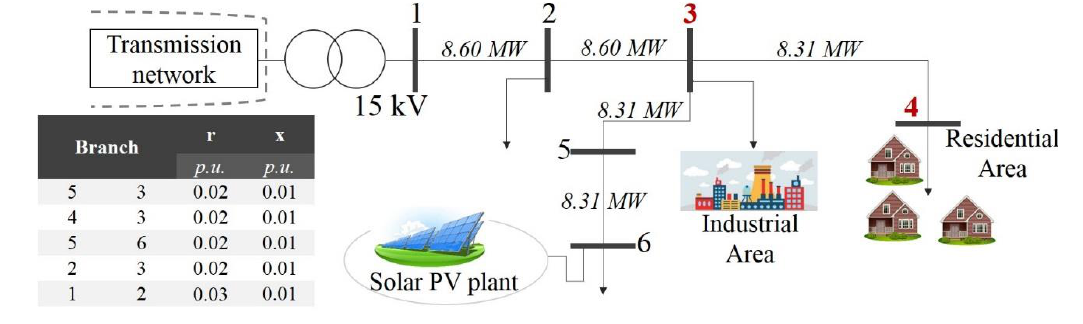
Figure 3. Case Study I: Distribution network feeder.